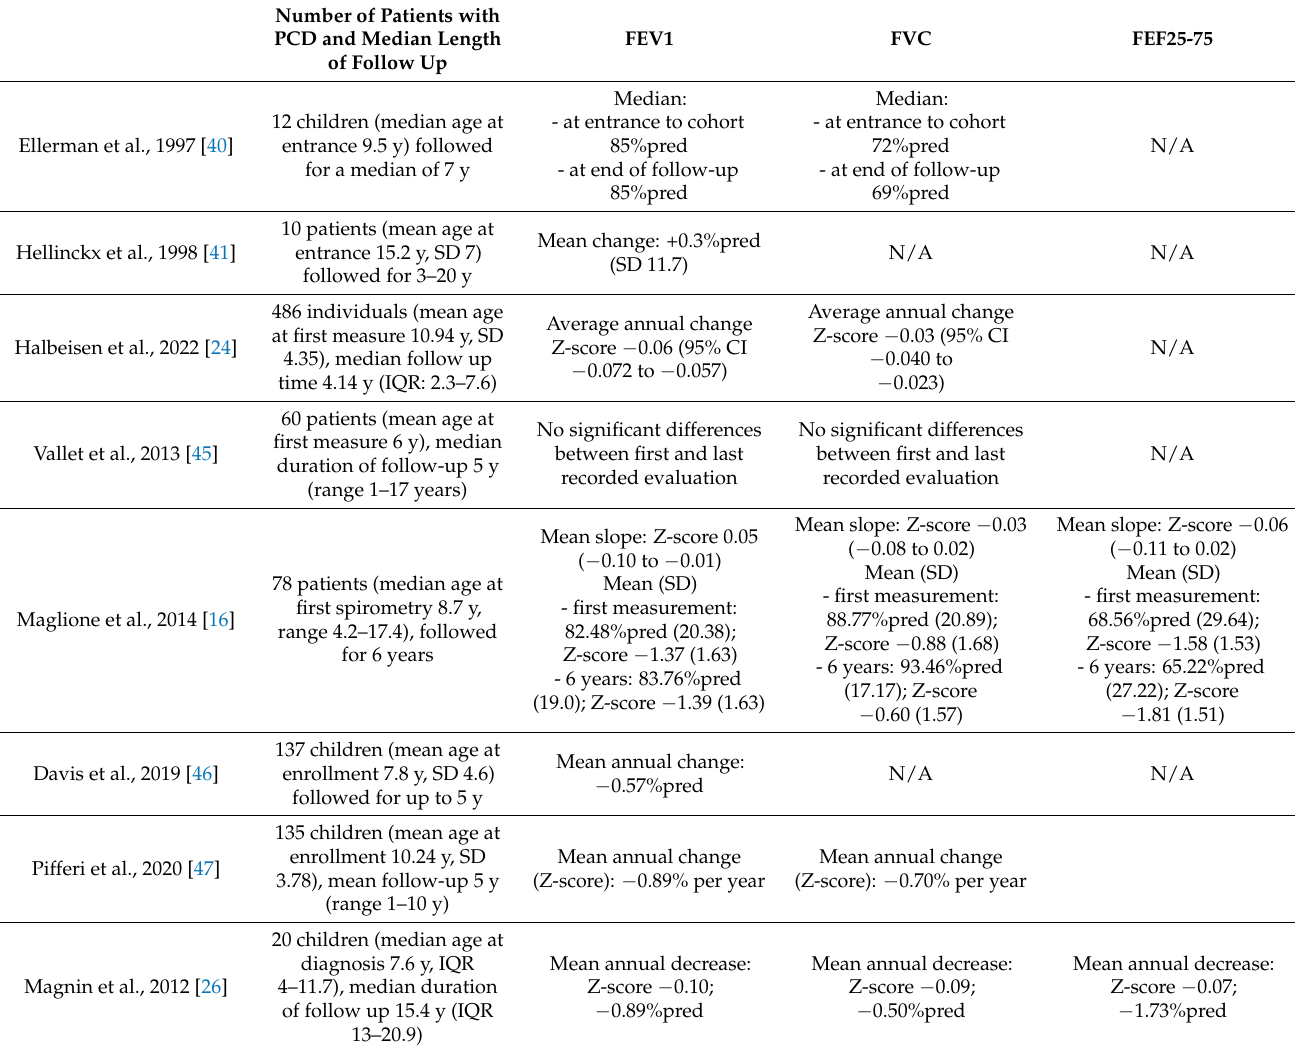
Table 2. Longitudinal course of spirometric values in patients with